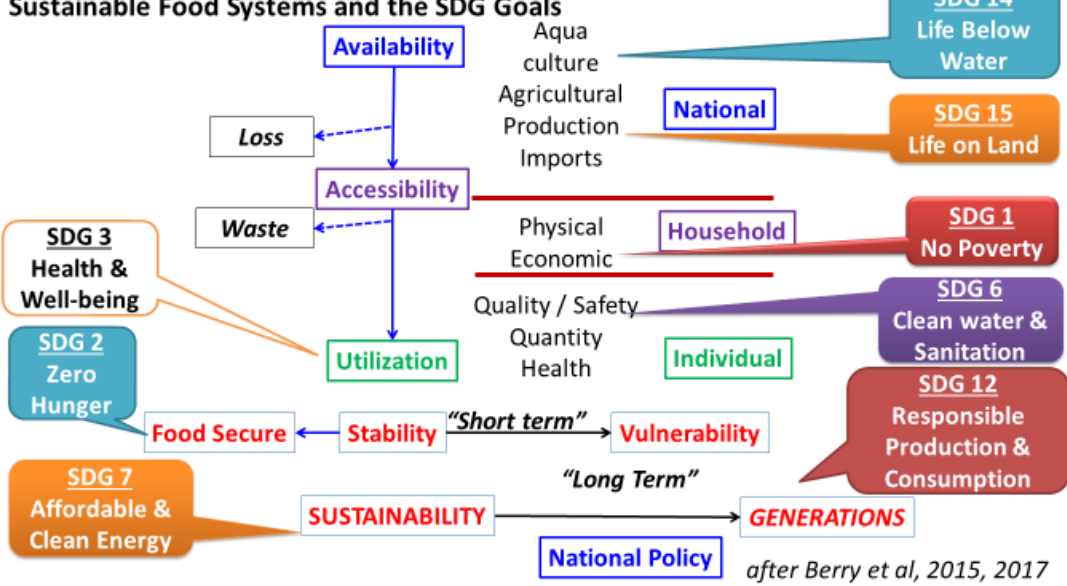
Figure 1. The relationships between the food security pathway and many of the sustainable development goals.